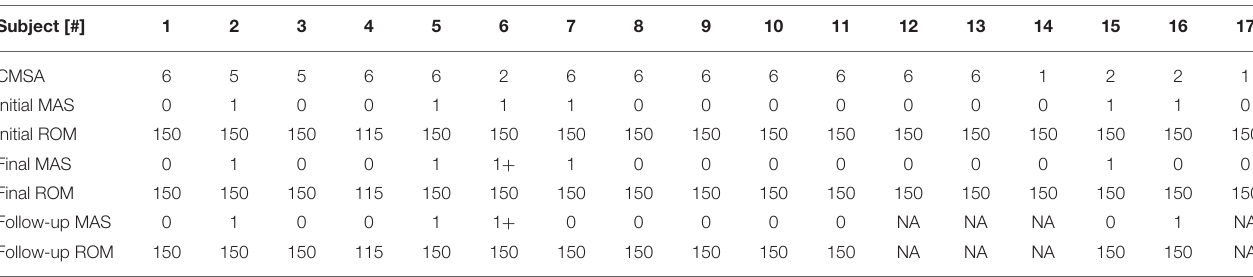
TABLE 1 | MAS scores and ROM values for each subject, assessed by physical therapists before and after the rehabilitation therapy with